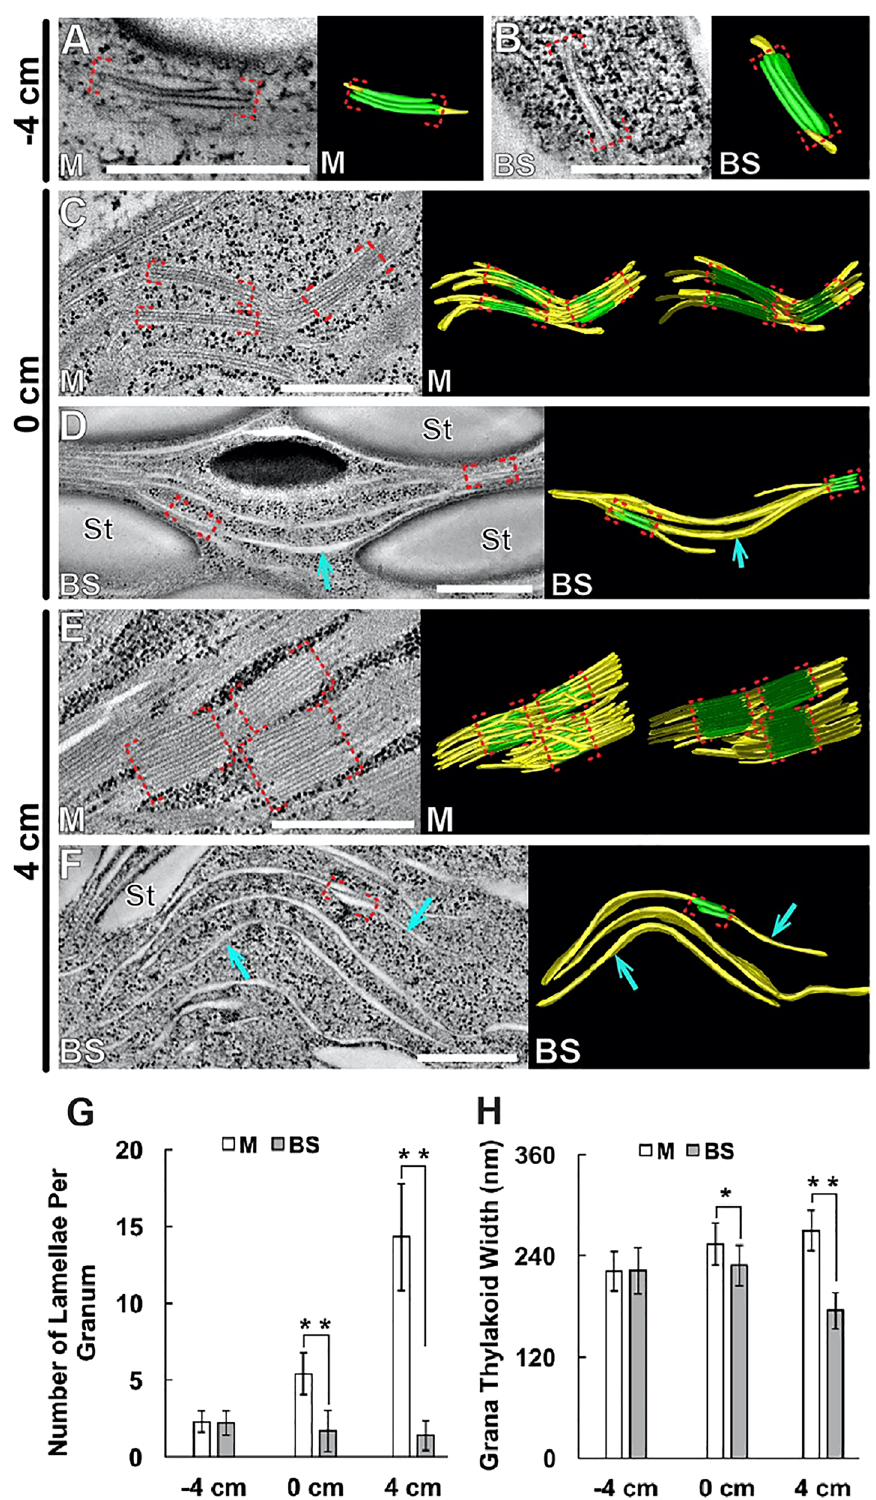
Figure 2. ET analysis of thylakoid assembly in chloroplasts of the maize leaf. (A–F) Tomographic slice images of thylakoids in M and BS chloroplasts (left) and 3D models (right) in ( A , B ) −4-cm, ( C,D ) 0-cm, and ( E,F ) 4-cm sections. Stacked and unstacked regions of thylakoids are colored in green and yellow, respectively in 3D models. Grana stacks were highlighted with red brackets, unstacked stroma lamellae are marked with blue arrows in ( D,F) . In panels (C,E) , the thylakoid models were clipped to reveal their stack architectures. Scale bars: 500 nm. (G) Average numbers of disks per granum in M and BS chloroplasts (n = 10 per cell type and stage). Error bars depict standard deviations (SDs) ( ** , p < 0.01; ns, not significant; Student’s t-test). (H) Average widths of grana stacks in M and BS chloroplasts (n = 10 per cell type and stage). Error bars depict SDs ( * , p < 0.05; ** , p < 0.01; Student’s